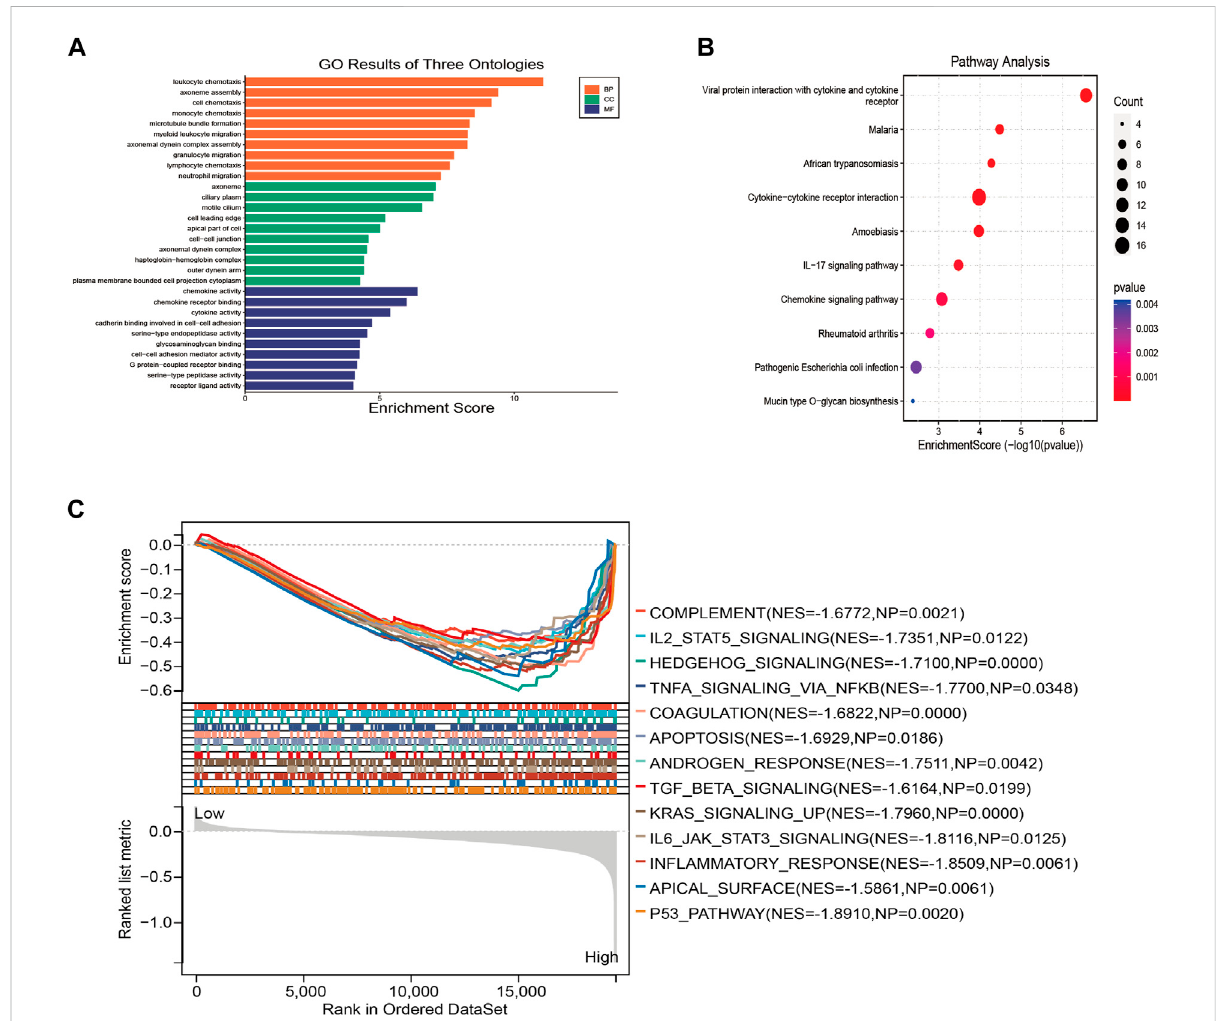
FIGURE 7 Functional enrichment analysis based on the DEGs from high-risk and low-risk groups in training cohort. (A) The results of GO pathway enrichment analysis. (B) The results of KEGG pathway analysis. (C) The enriched hallmarks of GSEA results based of the risk